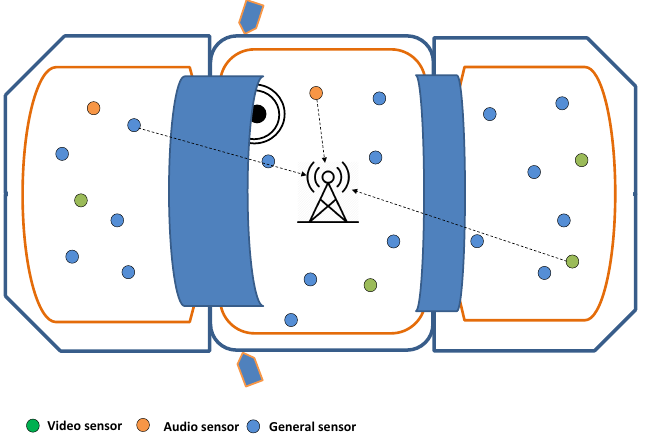
Figure 1. A vehicle installed with a finite number of sensors for wireless backbone